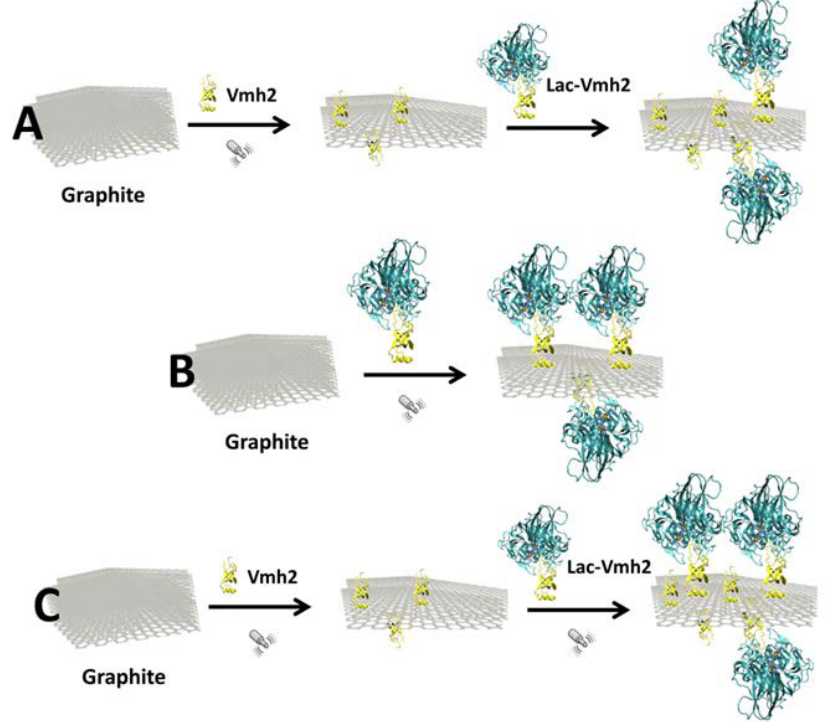
Figure 1. Tests performed to exfoliate and biofunctionalize graphite with laccase chimera, Lac-Vmh2. ( A ): graphite exfoliation in the presence of Vmh2 (~ 5h) and subsequent addition of Lac-Vmh2; ( B ): graphite exfoliation in the presence of both Vmh2 and Lac-Vmh2 (~ 5h); ( C ): graphite exfoliation in the presence of Vmh2 (~ 5h) and addition of Lac-Vmh2 in the last 10 min of exfoliation. Table 1. Summary of the sample enzymatic activity and their characteristics.